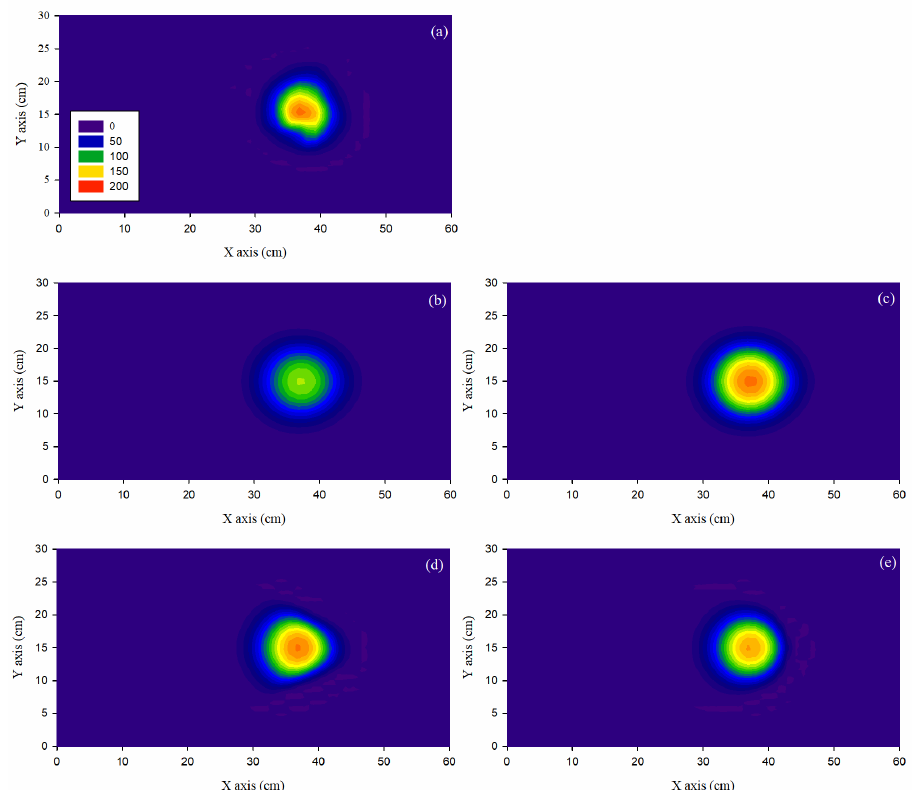
Figure 5. ( a ) Observed toluene plume, and the simulated using various sorption models (unit of contour mg/L): ( b ) kinetic-irreversible, ( c ) linear isotherm, ( d ) Freundlich isotherm and ( e ) Langmuir isotherm models.